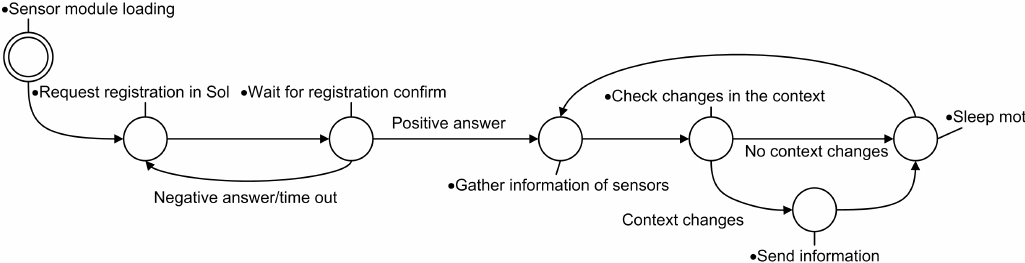
Figure 7. State transition diagram representing the main behavior of SensorAgents running Libelium